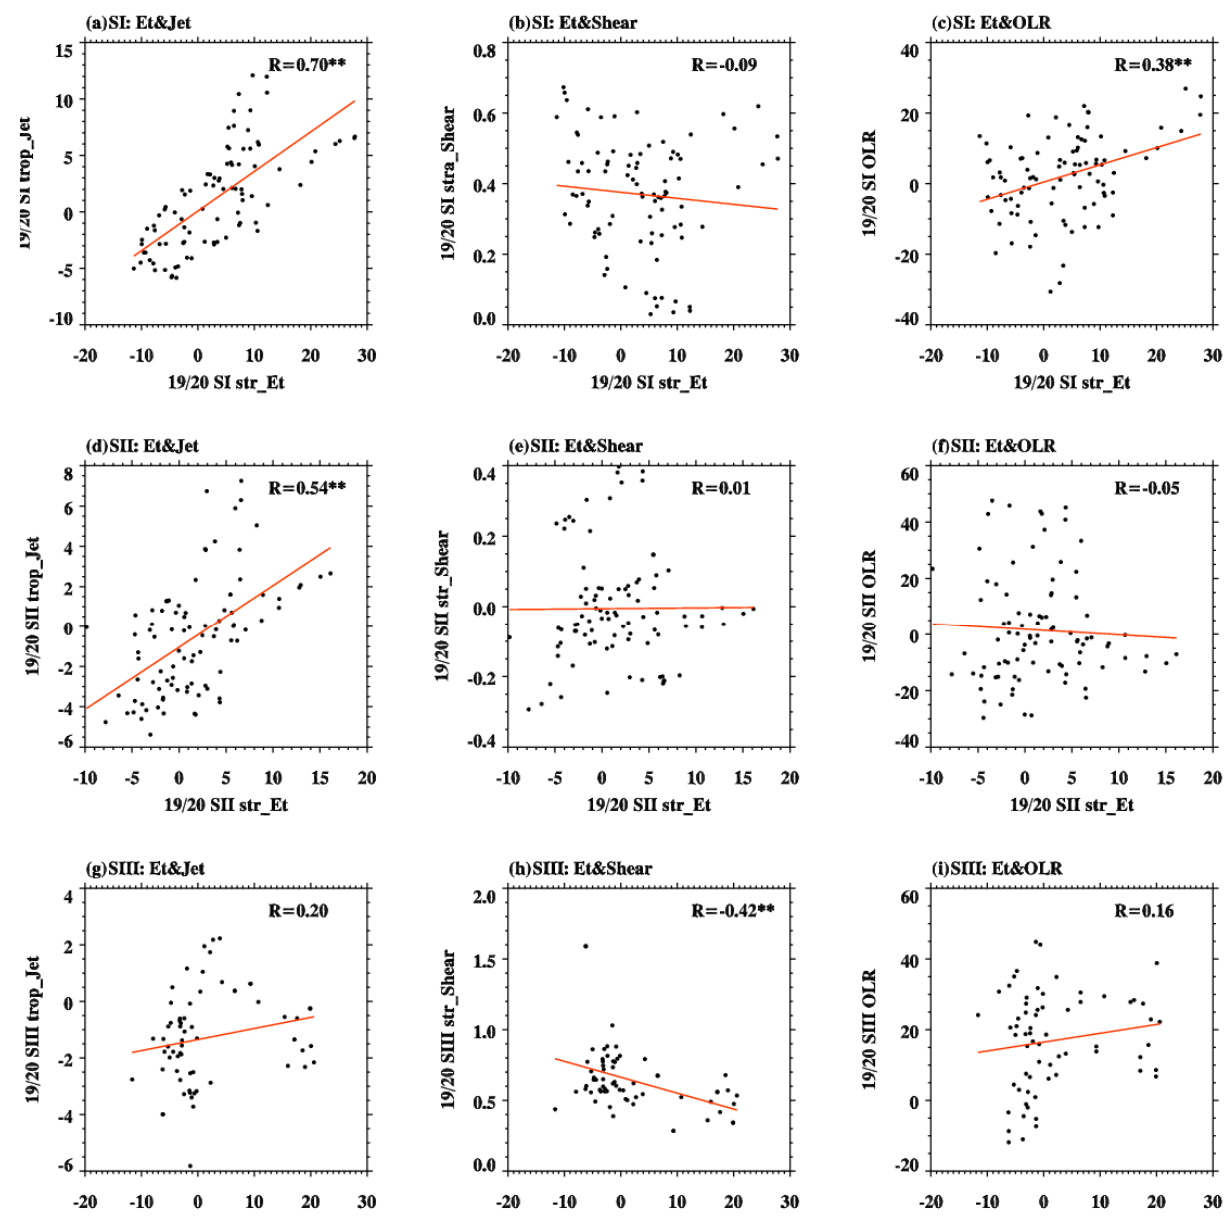
Figure 6. Panels ( a , d , g ) display the scatterplots between tropospheric jet anomaly and the stratospheric GW total energy density anomaly in SI, SII, and SIII stages in the 2019/2020 event, respectively. Panels ( b , e , h ) are similar to panels ( a , d , g ) but instead display the scatterplots between stratospheric vertical shear anomaly and stratospheric GW total energy density anomaly in SI, SII, and SIII stages in 2019/2020, respectively. Panels ( c , f , i ) are similar to above panels but instead display the scatterplots between detrended OLR and stratospheric GW total energy density anomaly in SI, SII, and SIII in the 2019/2020 event, respectively. The lines denote the fit line. The correlation coefficients between each factor and the stratospheric GW total energy density anomaly are displayed in the upper right corner of each panel. The double asterisk (“**”) denotes a significant level larger than